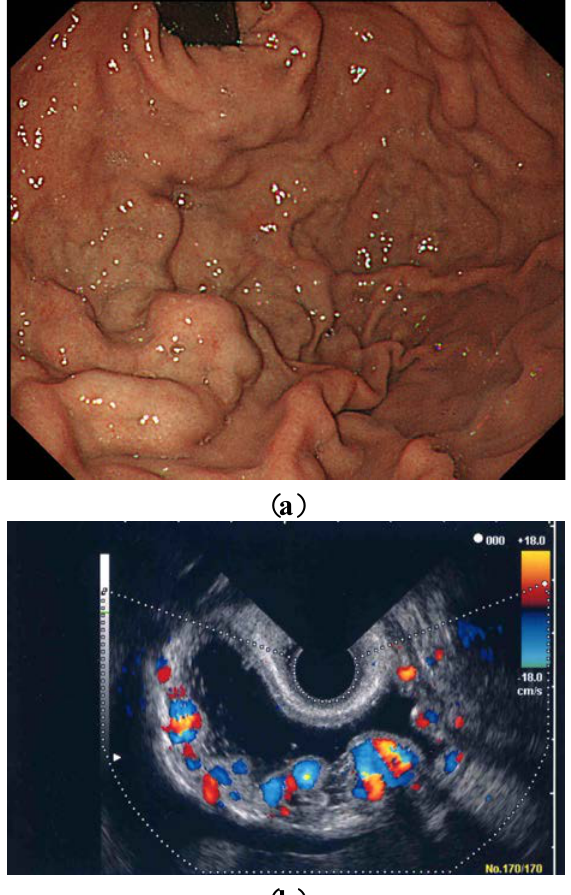
Figure 4. ( a ) Endoscopic findings showing enlarged tortuous, erosion-positive gastric varices in the round fundal region at the center; ( b ) Color flow images from endoscopic color Doppler ultrasonography showing a round fundal region at the center, with varices expanding to the curvatura ventriculi major of the gastric